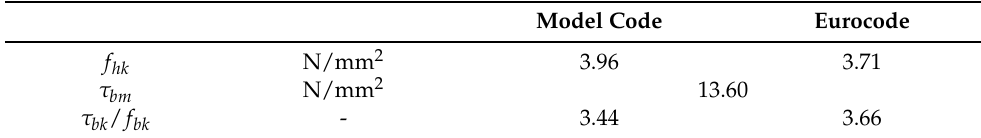
Table 4. Characteristic bond stress